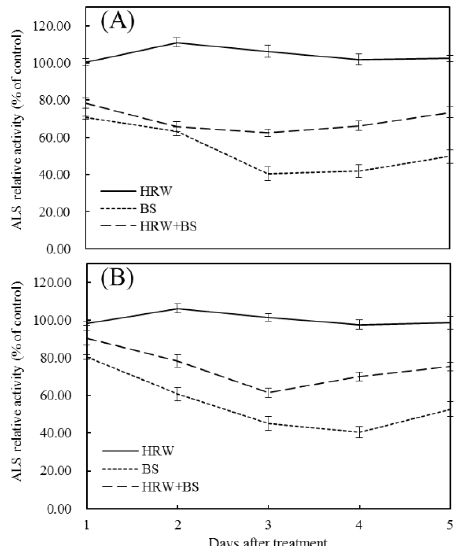
Figure 2. Changes in ALS (acetolactate synthase) enzyme activity in response to different treatments over time. HRW and BS indicate treatment with HRW (hydrogen-rich water) and BS (Bispyribac-sodium) alone, respectively; HRW + BS indicates the co-treatment with HRW and BS. ALS enzyme activity in untreated rice seedlings was defined as the 100% baseline, this being 308.03 nmol acetoin mg − 1 protein h − 1 in indica rice ( A ) and 295.40 nmol acetoin mg − 1 protein h − 1 in japonica rice ( B ). Symbols are the means from three independent experiments. Error bars indicate the standard error.